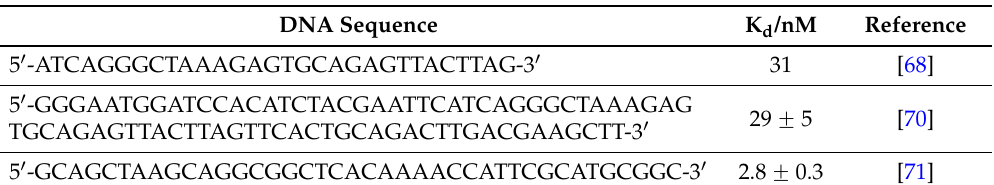
Table 1. DNA sequence of different lysozyme